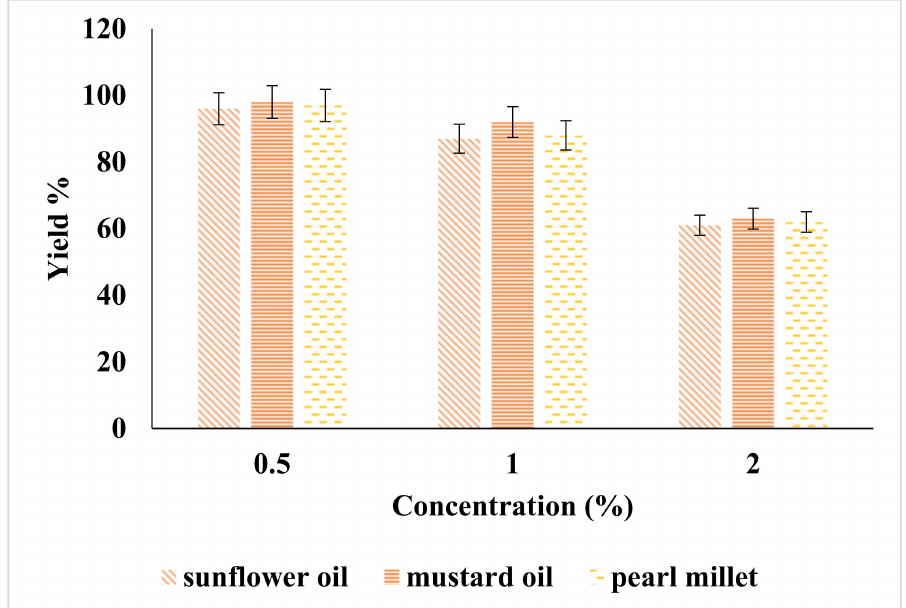
Figure 1. Percentage yield of biodiesel using KOH (wt.%) as a base catalyst.